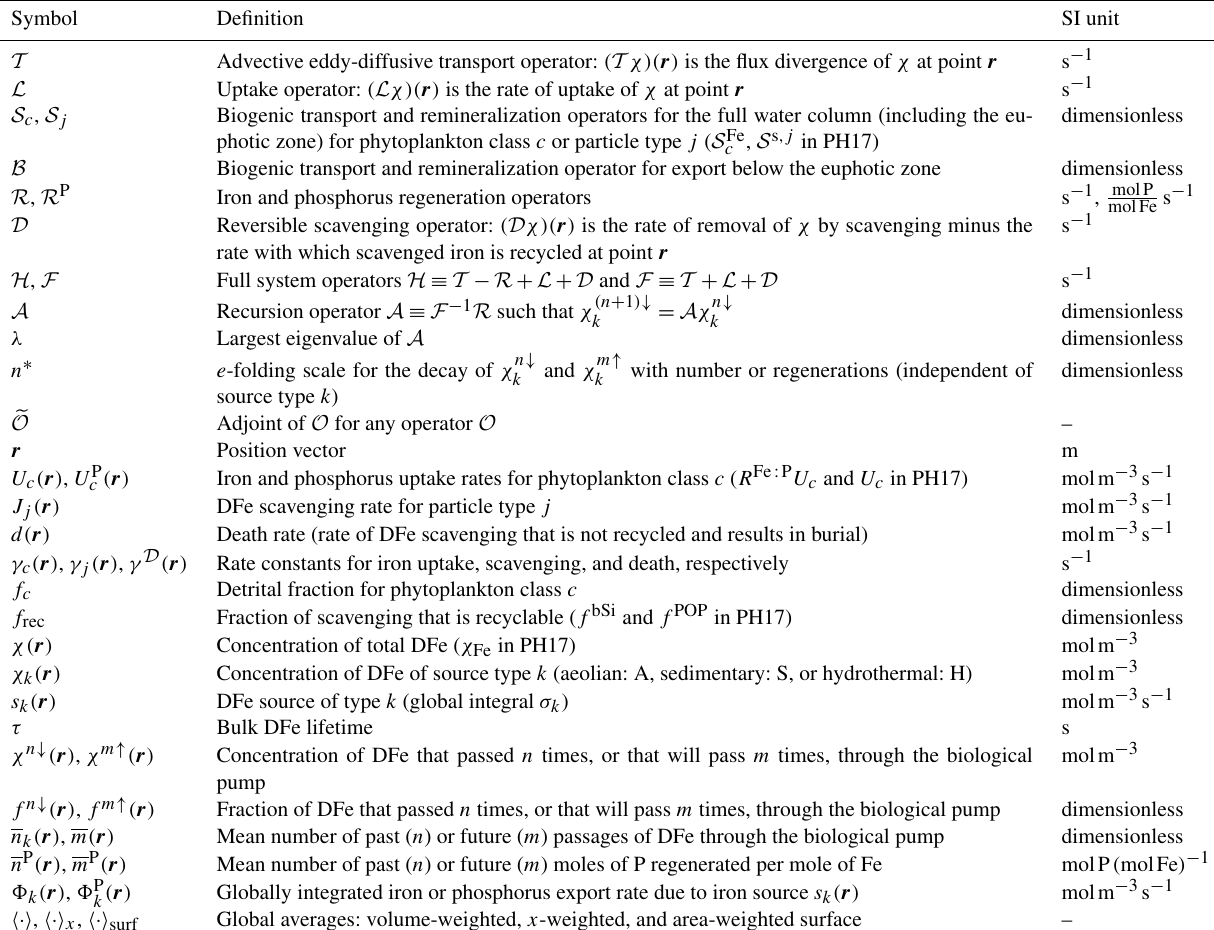
Table A1. Glossary of mathematical symbols, their definitions, and SI units (PH17 refers to Pasquier and Holzer, 2017).